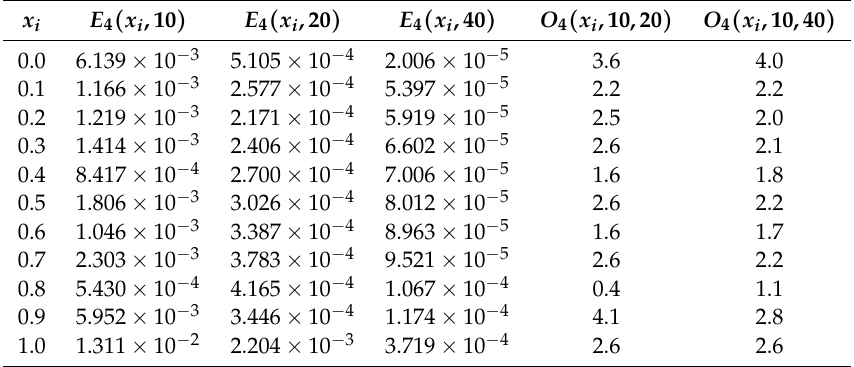
Table 6. The absolute errors of the fourth order derivatives of y 1 at the knots and the numerical convergence